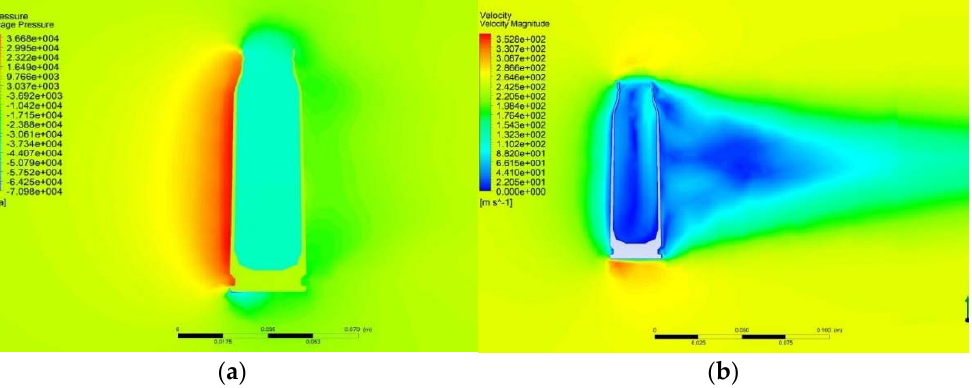
Figure 8. Shell case vertical to free stream: ( a ) gauge pressure contour and ( b ) velocity magnitude.